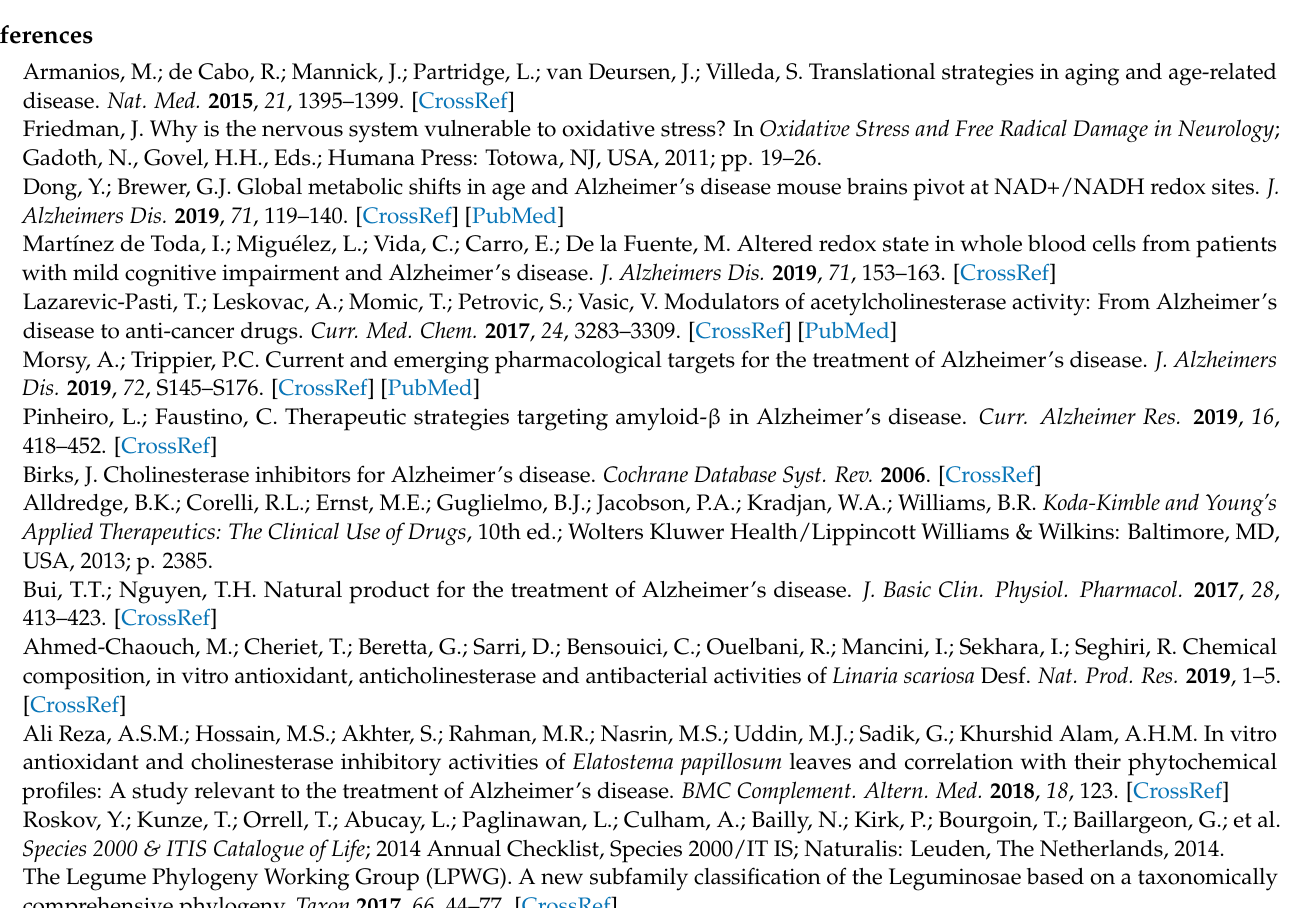
Table S1: BChE assay results for EEBC and four marker